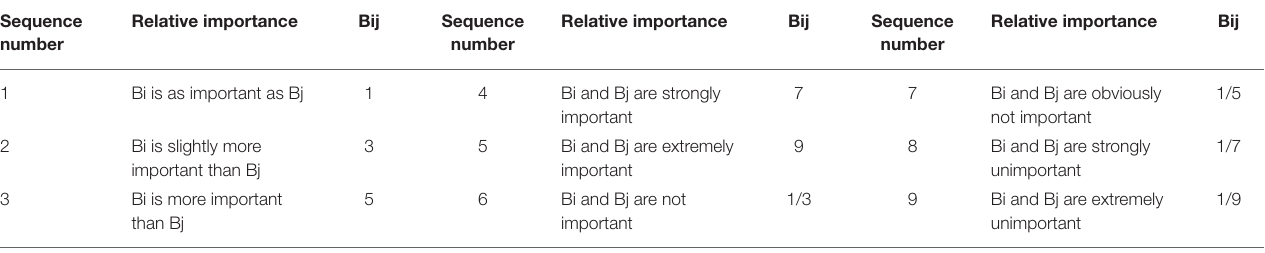
TABLE 14 | Assignment rules of analytic hierarchy process.